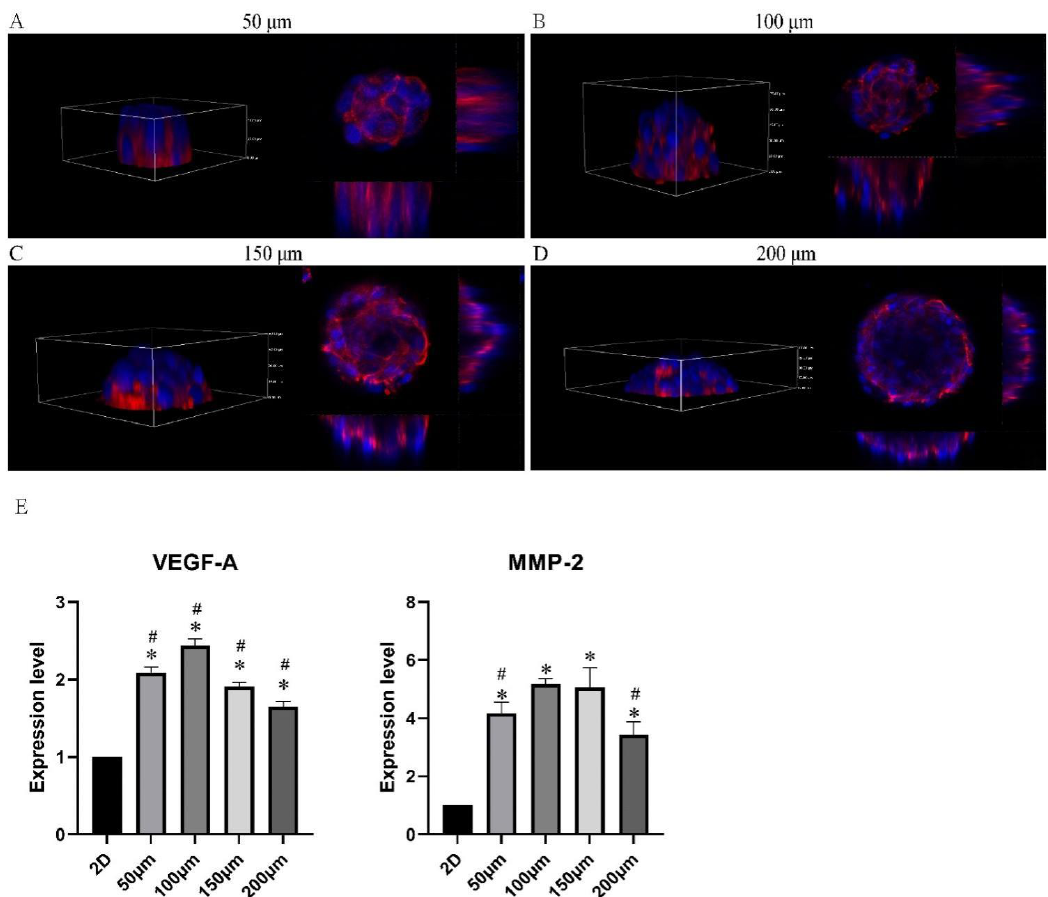
Figure 4. Characteristics of the CD31+ HemEC microtumors. ( A – D ) Three-dimensional view of CD31+ HemEC microtumors in micropattern arrays with 50, 100, 150, and 200 µ m diameters by confocal microscopy. ( E ) Gene expression levels of MMP-2 and VEGF-A in CD31+ HemEC micro- tumors with different diameters. * p < 0.05 compared to the 2D culture; # p < 0.05 compared to the 100 μm diameters.